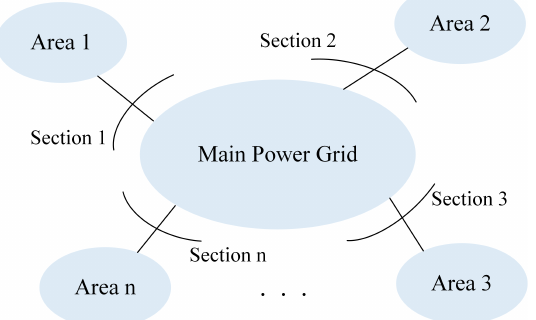
Figure 1. Structure diagram of the aggregation model of a power